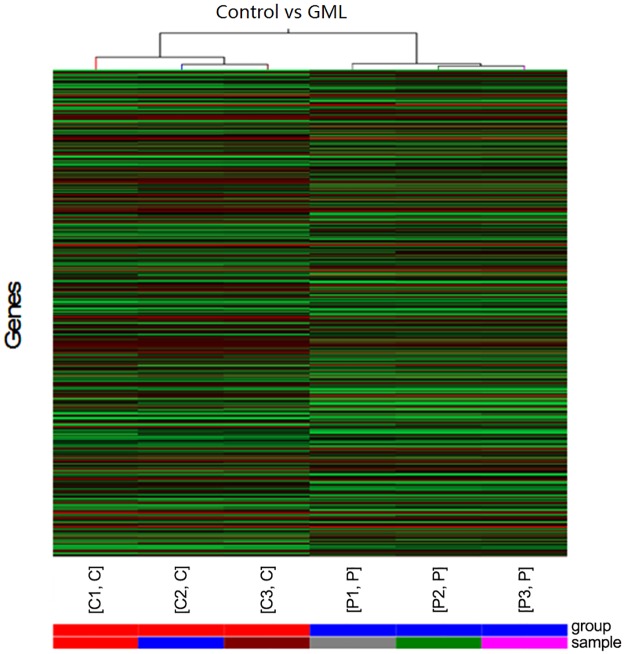
Hierarchical cluster analysis of the altered genes in the gastric mucosa of GML patients.The color code in each heat map was linear with green as the lowest and red as the highest. The increased genes expression was shown in green to red, whereas the decreased genes expression was shown from red to green.